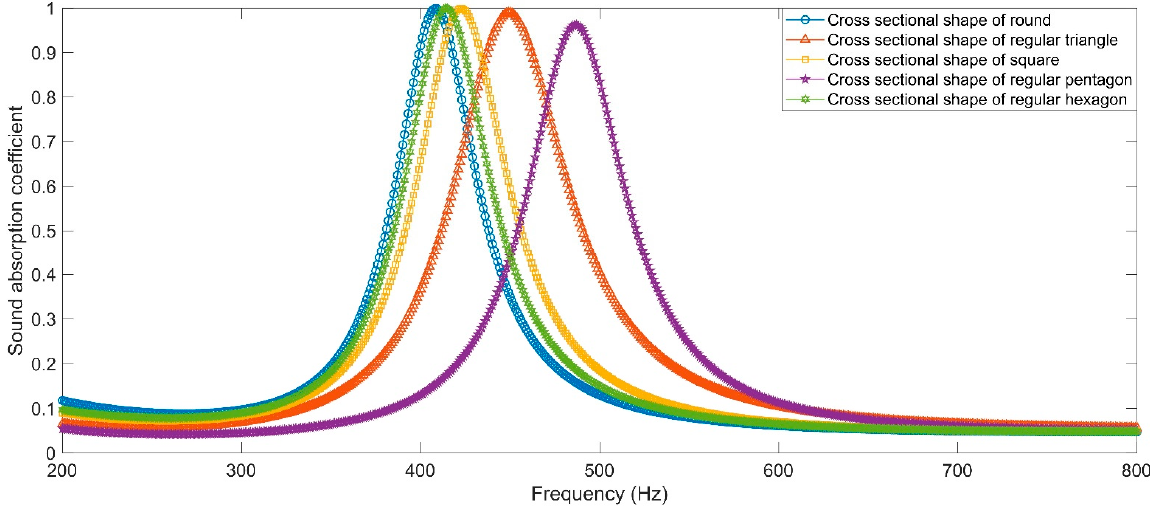
Figure 12. Sound absorption performance of HRs with aperture for various cross sectional